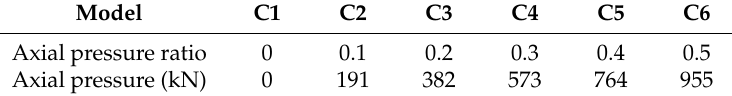
Table 6. Axial compression ratio.